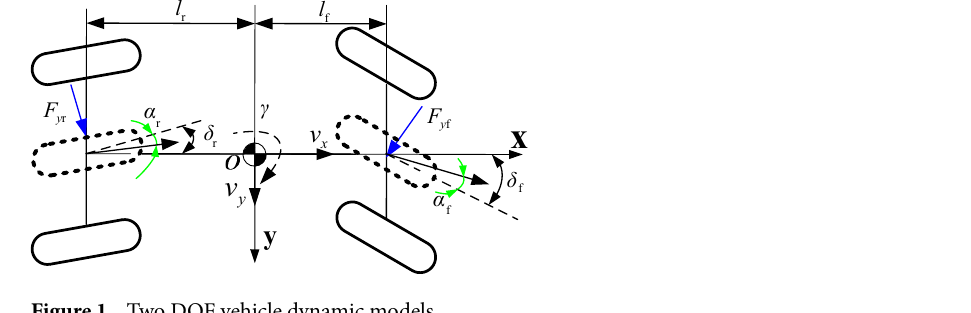
Figure 1. Two DOF vehicle dynamic